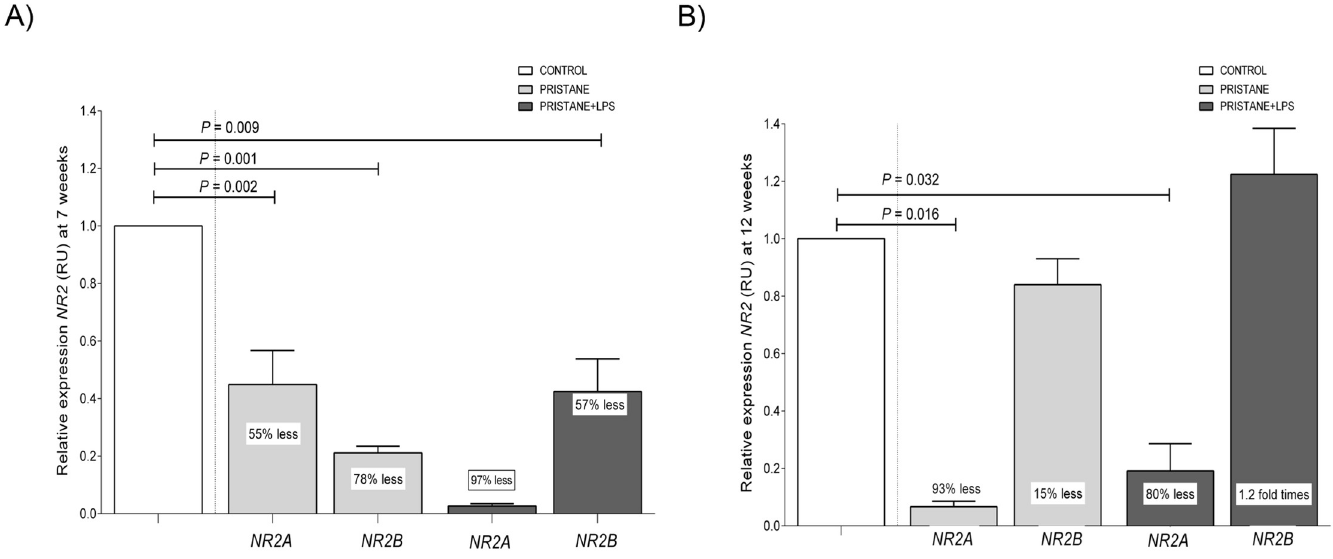
Fig 4. NR2A/2B subunit expression of the murine hippocampus at 7 and 12 weeks. Data are shown in � x ± MSE, differences between groups unpaired Mann Whitney U test, P < 0.05. A) Relative expression of NR2A and NR2B at 7 weeks. B) Relative expression of NR2A and NR2B at 12